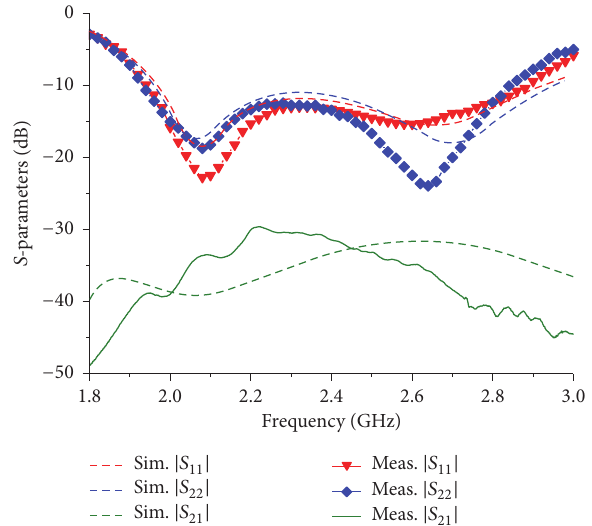
Figure 12: Measured and simulated 𝑆 -parameters of the proposed